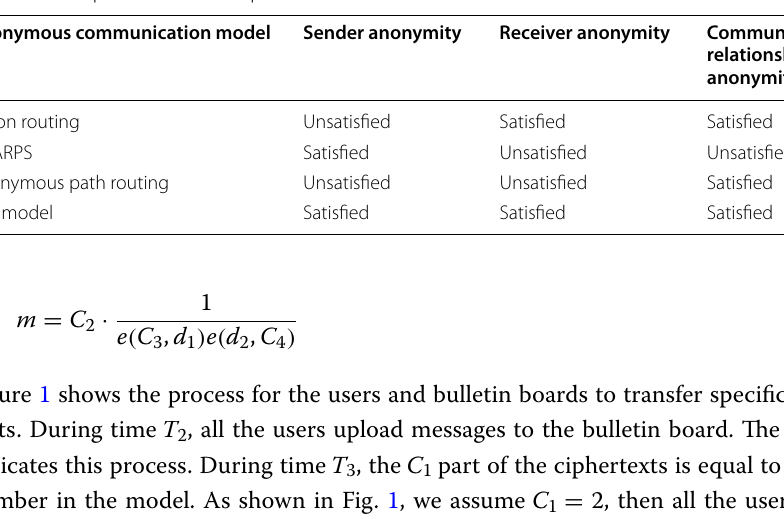
Table 2 Comparison of model